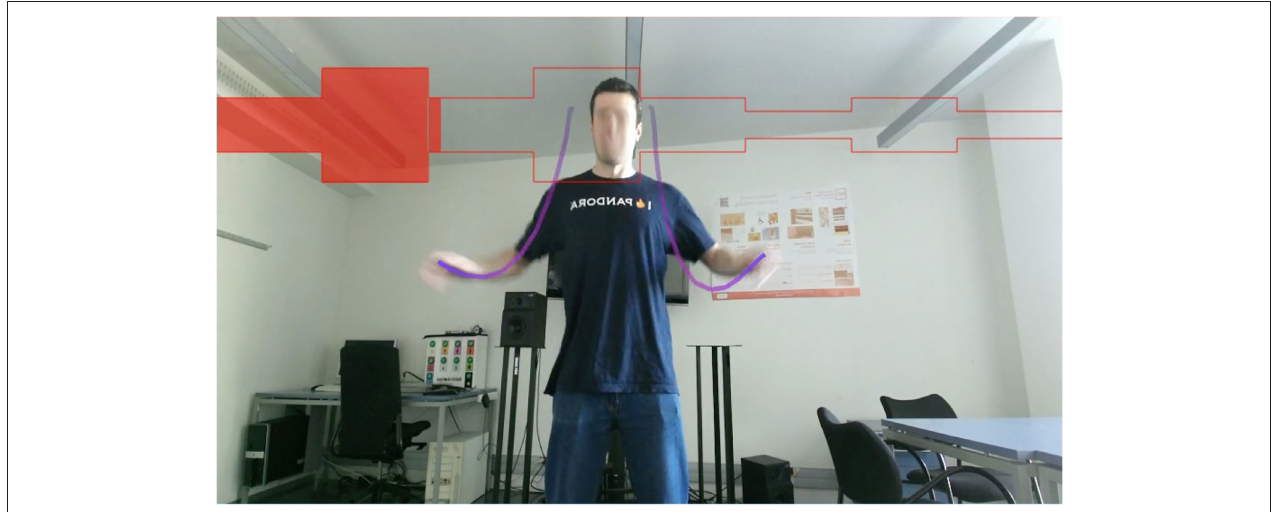
FIGURE 3 | Visualization shown during warm up phase. All participants gave written informed consent for the publication of all the recorded material during the experiment, including